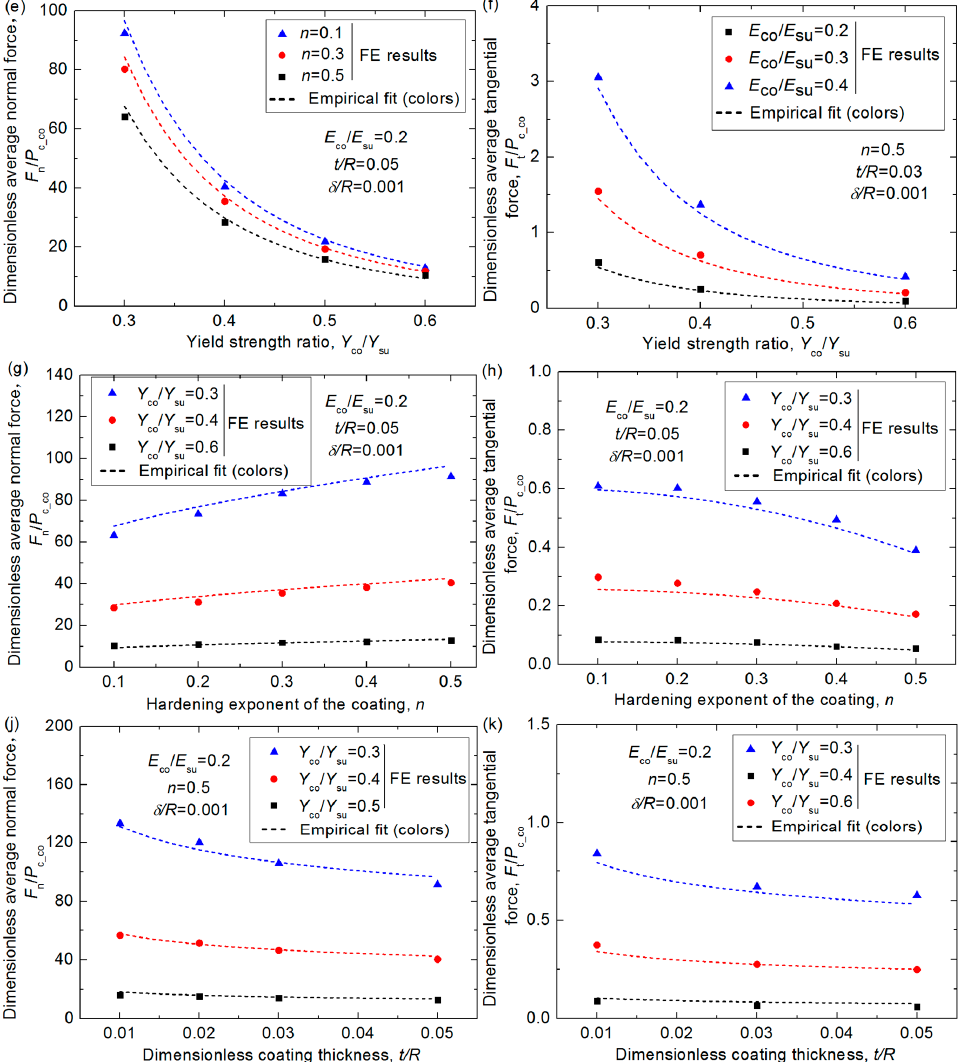
Figure 6. The dimensionless average normal and tangential force, F n / P c_co and F t / P c_co , under different normal interferences, δ /R , for different cases where Young’s modulus ratios, E co / E su , yield strength ratios, Y co / Y su , hardening exponent, n , and thickness, t/R , of the coating changes in different specific range. ( a ) The effect of δ /R on F n / P c_co ; ( b ) The effect of δ /R on F t / P c_co ; ( c ) The effect of E co / E su on F n / P c_co ; ( d ) The e ff ect of E co / E su on F t / P c_co ; ( e ) The e ff ect of Y co / Y su on F n / P c_co ; ( f ) The e ff ect